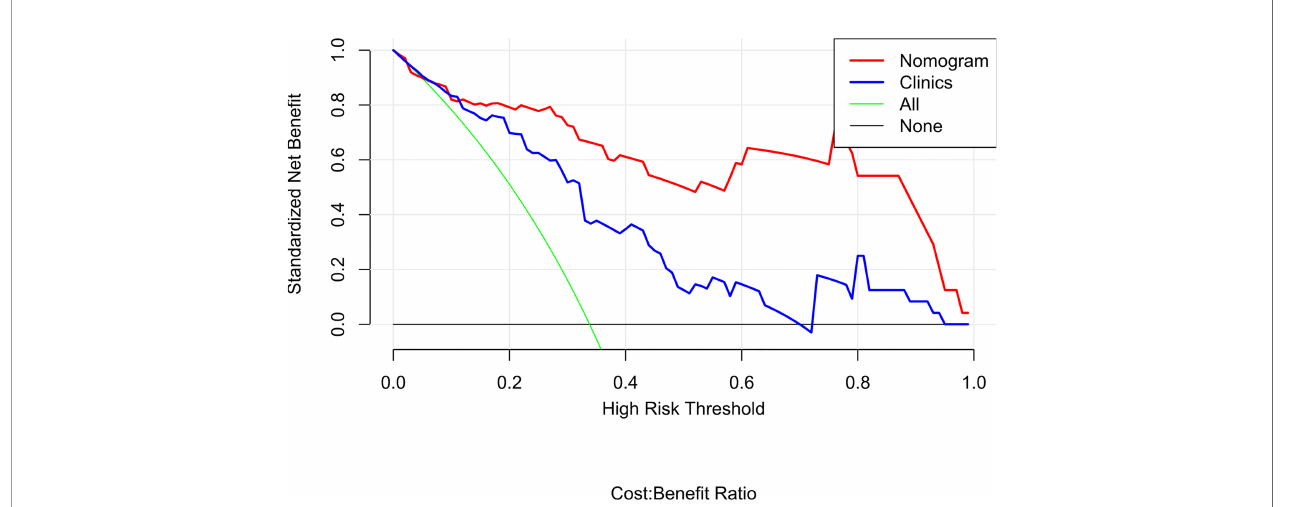
FIGURE 8 | Decision curve analysis (DCA) for the radiomics nomogram and clinics model. The DCA indicated that more net bene fi ts within the most of thresholds probabilities were achieved using the radiomics